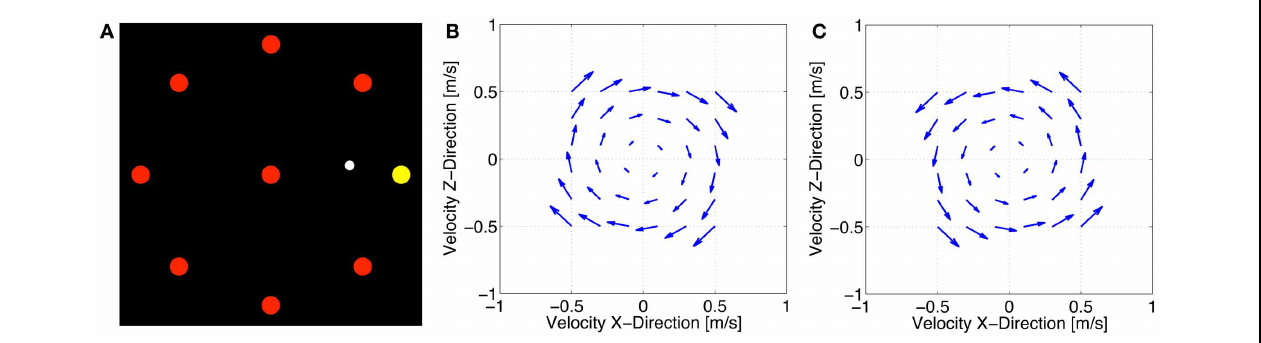
FIGURE 2 | Center-out task (A), velocity-dependent clockwise force field (B), and velocity-dependent counterclockwise force field (C).